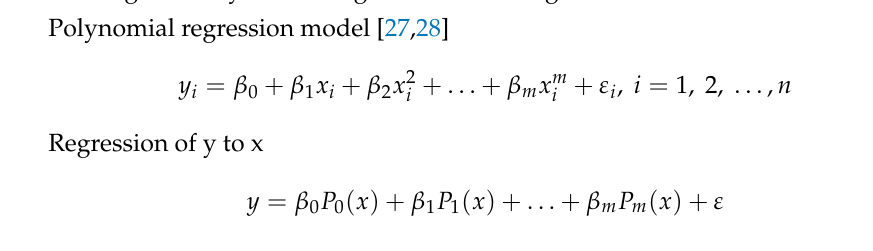
Table 5. The orthogonal test table and experimental result.